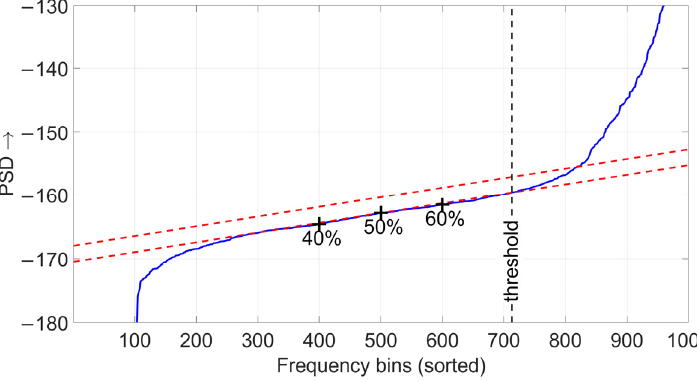
8 of 16 Figure 6. Spectrogram of a 1-h fragment of the unprocessed measurements, as an example. 3.6. A Novel Adaptive Filter for the Removal of Narrowband Radio Signals To retain the background ambient noise and at the same time remove the radio signals, an adaptive filter is realized. Using the statistical information of the samples produced by each FFT, a dynamic threshold is set to distinguish the frequency components of the background ambient noise from the discrete radio signals. Based on this threshold, the radio signals are removed in the frequency domain. The threshold is determined by sorting the frequency bins of each FFT on increasing PSD; see Figure 7. The median value is established, as well as the slope of the tangent at this point. The slope is determined from the data points at 40% and 60% of the sorted values. This was carried out by drawing a straight line through these two data points, but a more robust way would be to use linear regression on all data points between the 40% and 60% data points. A second line parallel to the tangent is drawn, adding a small margin